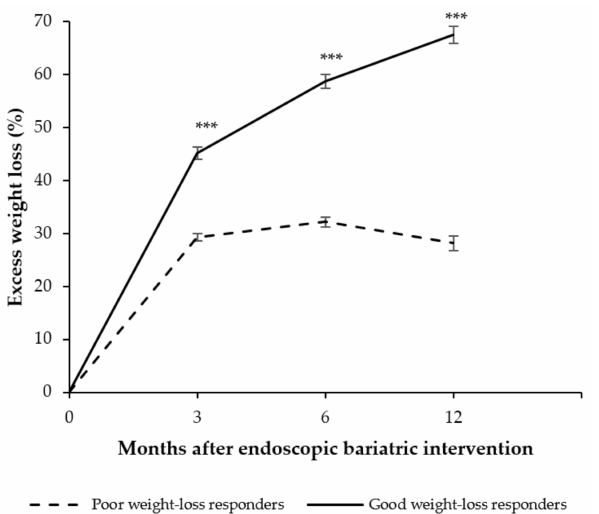
Figure 2. Evolution of weight loss at 3, 6, and 12 months after the endoscopic bariatric therapy. Values are expressed as mean and standard error measure. General linear models were used to compare the percentage of excess weight loss between good and poor weight-loss-responders. Analyses were adjusted for age, gender, initial BMI, and type of endoscopic bariatric therapy. *** p <